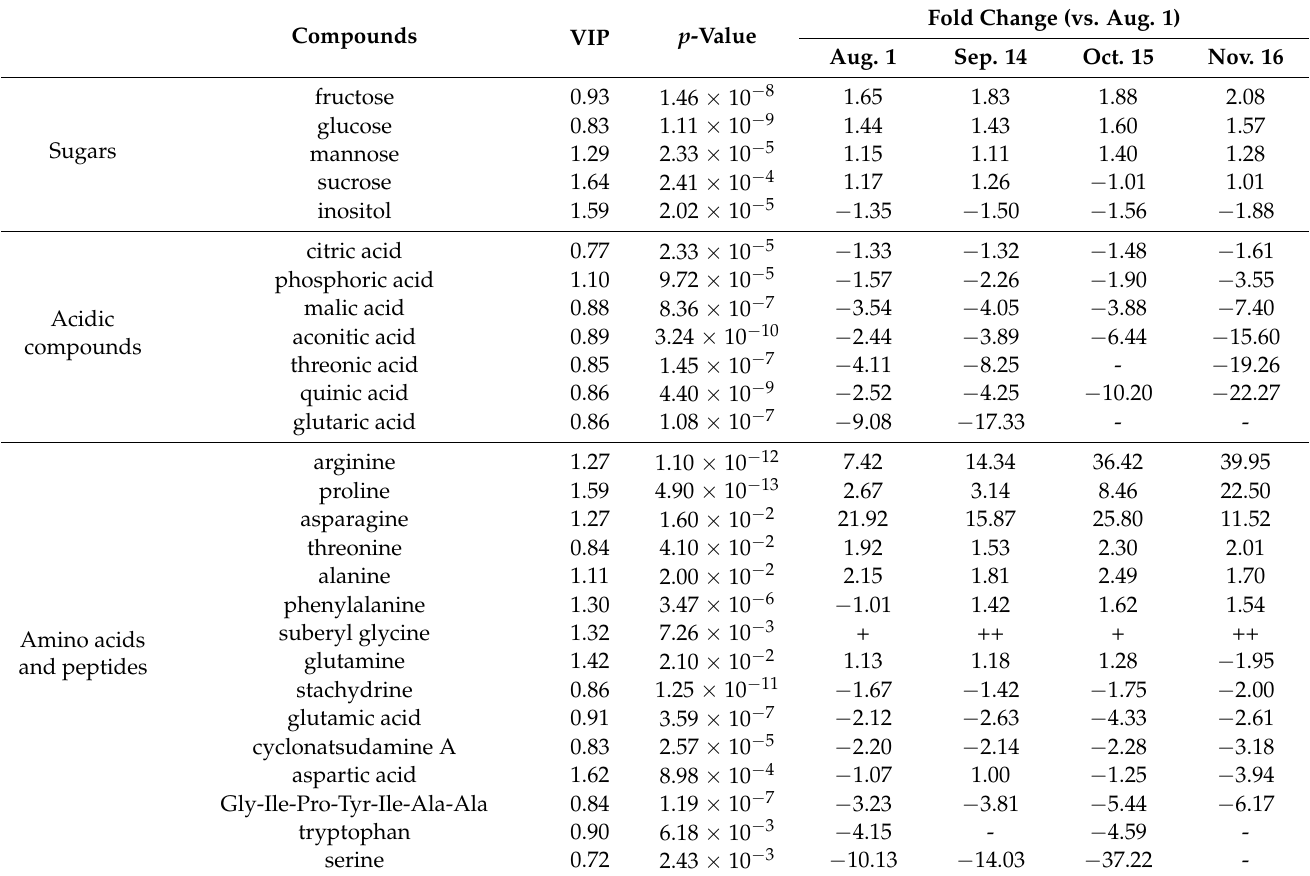
Table 1. Identification of the major metabolites from Citrus unshiu flesh contributing to the difference of samples in the PLS-DA score plot and their fold